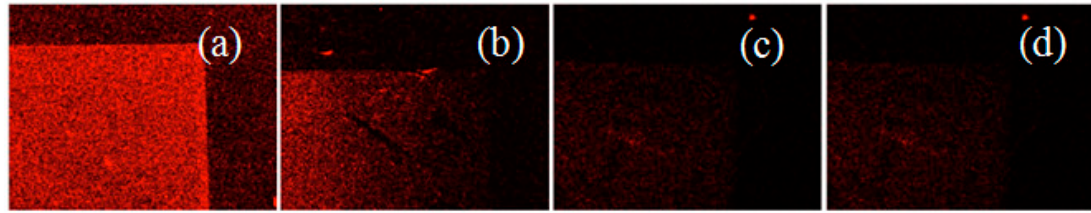
Figure 5. In situ Fluorescent signal measurements after thrombin (10 µ M) injection at ( a ) 0 min ( b ) 4.5 min ( c ) 9 min and ( d ) 15 min.